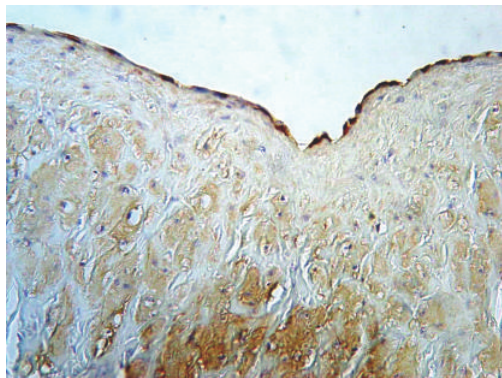
Figure 5: Continuous eNOS cytoplasmatic expression in the endothelial lining of the control (healthy) vein sample (magnifica- tion 400x,